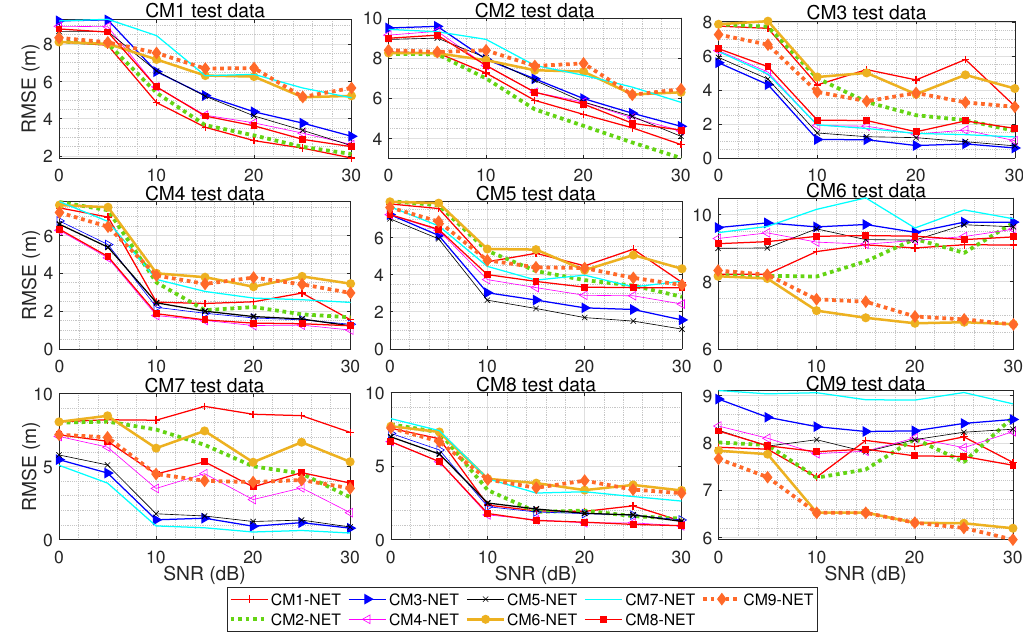
Figure 8. RMSE ( y -axis) across SNR ( x -axis). CM#-NET is a CNN that is trained by using data generated under CM# model. CM#-NET is tested with various